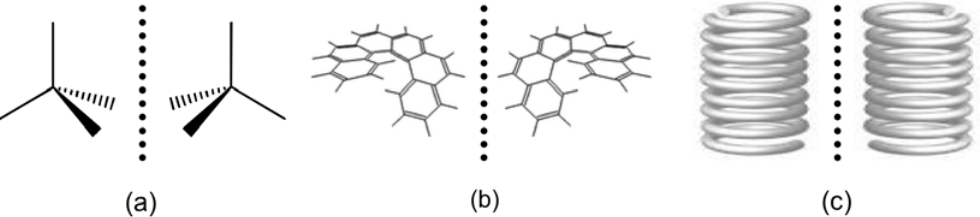
Figure 16. Schematics of ( a ) molecular chirality; ( b ) conformational chirality; and ( c ) supramolecular